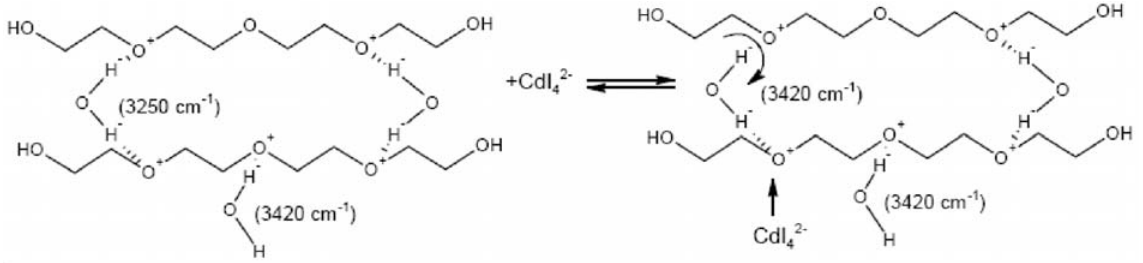
Fig. 7 “Fixation” of CdI 2 − in PEG-rich phases, according to the IR 4